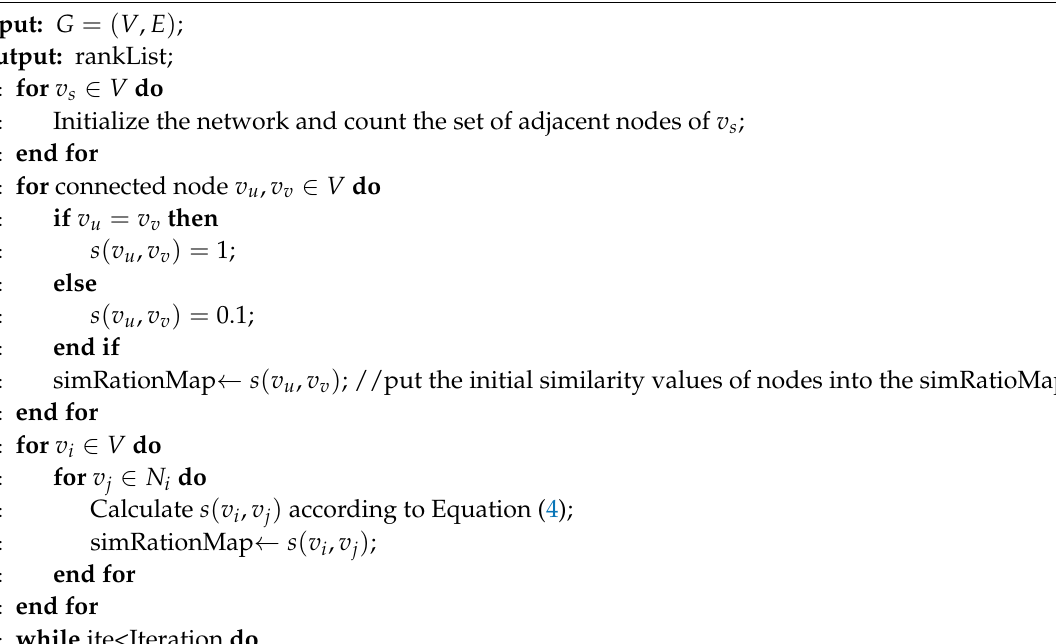
Algorithm 1 Trust–PageRank